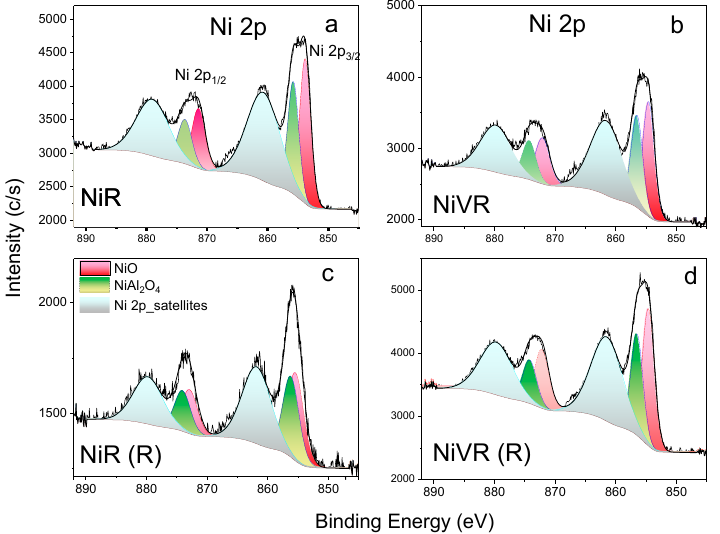
Figure 4. The HR-XPS data for Ni 2p region with deconvoluted spectra for NiR and NiVR catalysts fresh ( a,b ) and reduced ( c,d ) ((R) 5% H 2 in He).